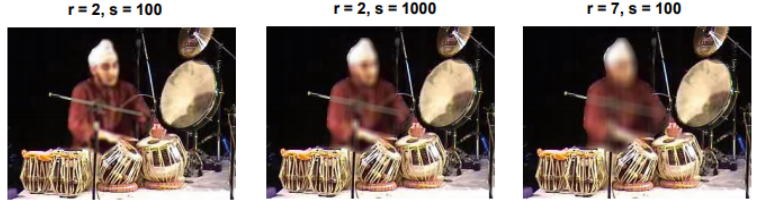
Figure 5. Different visual effects with different parameters of Gaussian